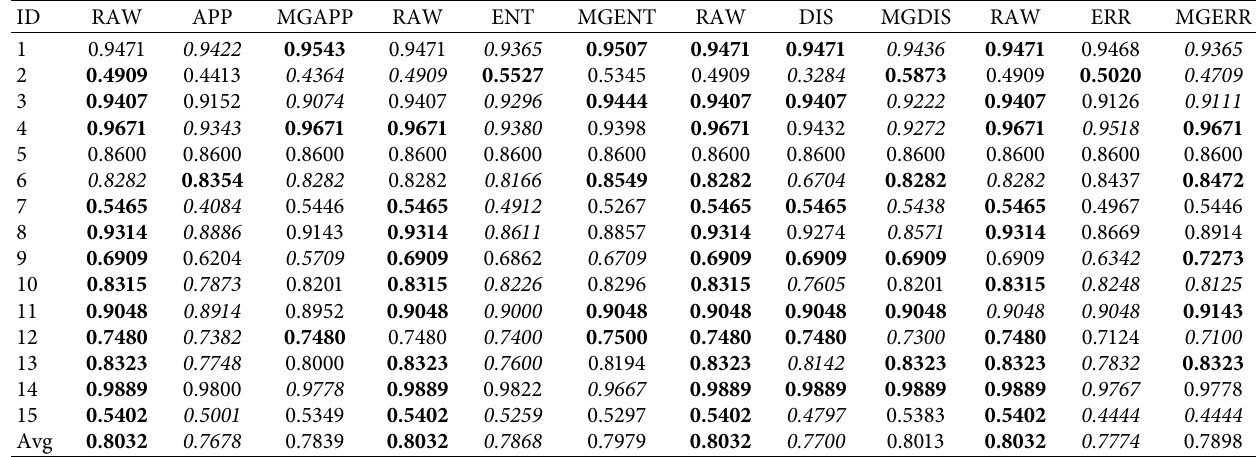
Table 7: Comparisons among the classification accuracies with using SVM.